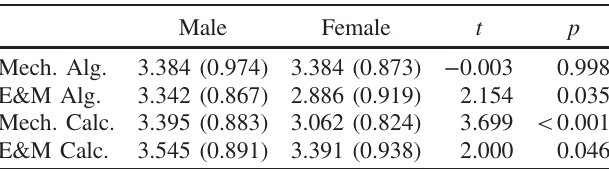
TABLE IX. Average student performance perception (and standard deviation) for each course, as well as the t test and significance between these distributions.